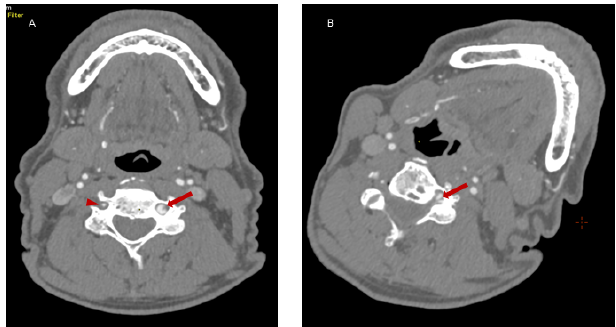
Figure 2. Dynamic CT angiography in the neutral head position and left-side rotation. Panel ( A ): Axial D-CTA in the neutral head position demonstrates L-VA loop in V2 segment (red arrow ) at C4 level and R-VA hypoplasia ( red arrowhead ). No L-VA stenosis in this position. Panel ( B ): Axial D-CTA in left-side head rotation demonstrates the narrowing of L-VA lumen (up to 2 mm × 3.2 mm) that causes a dynamic 60% L-VA stenosis in the loop at C4 level ( red arrow ).